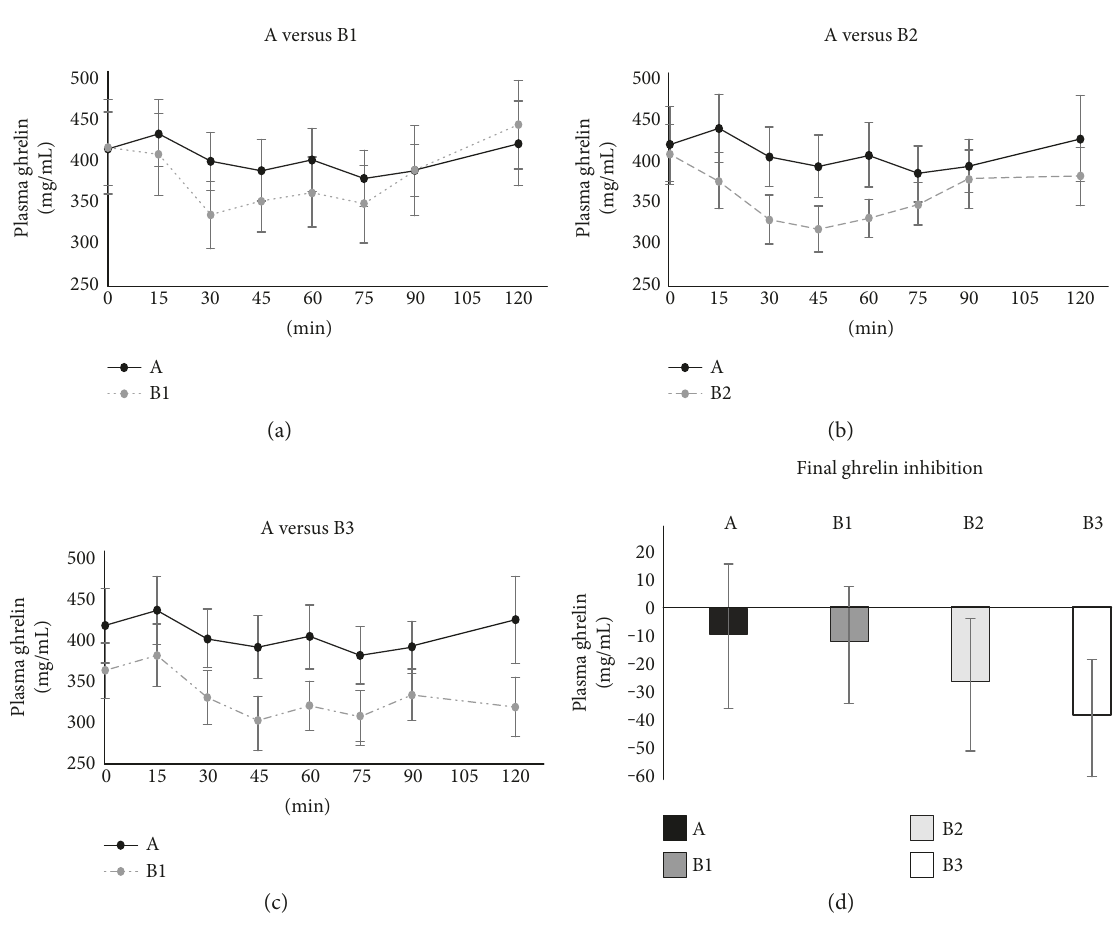
Figure 3: The time courses of ghrelin concentrations following breakfasts (a) B1, (b) B2, and (c) B3, respectively. For the sake of comparison, each of the three panels also displays the time course of ghrelin concentration measured after glucose ingestion (black line, glucose). (d) The fi nal (90 – 120min) ghrelin level (expressed as change with respect to the baseline) for each test. None of the di ff erences among the three breakfasts (B1, B2, and B3) and glucose ingestion (A) achieved the statistical signi fi